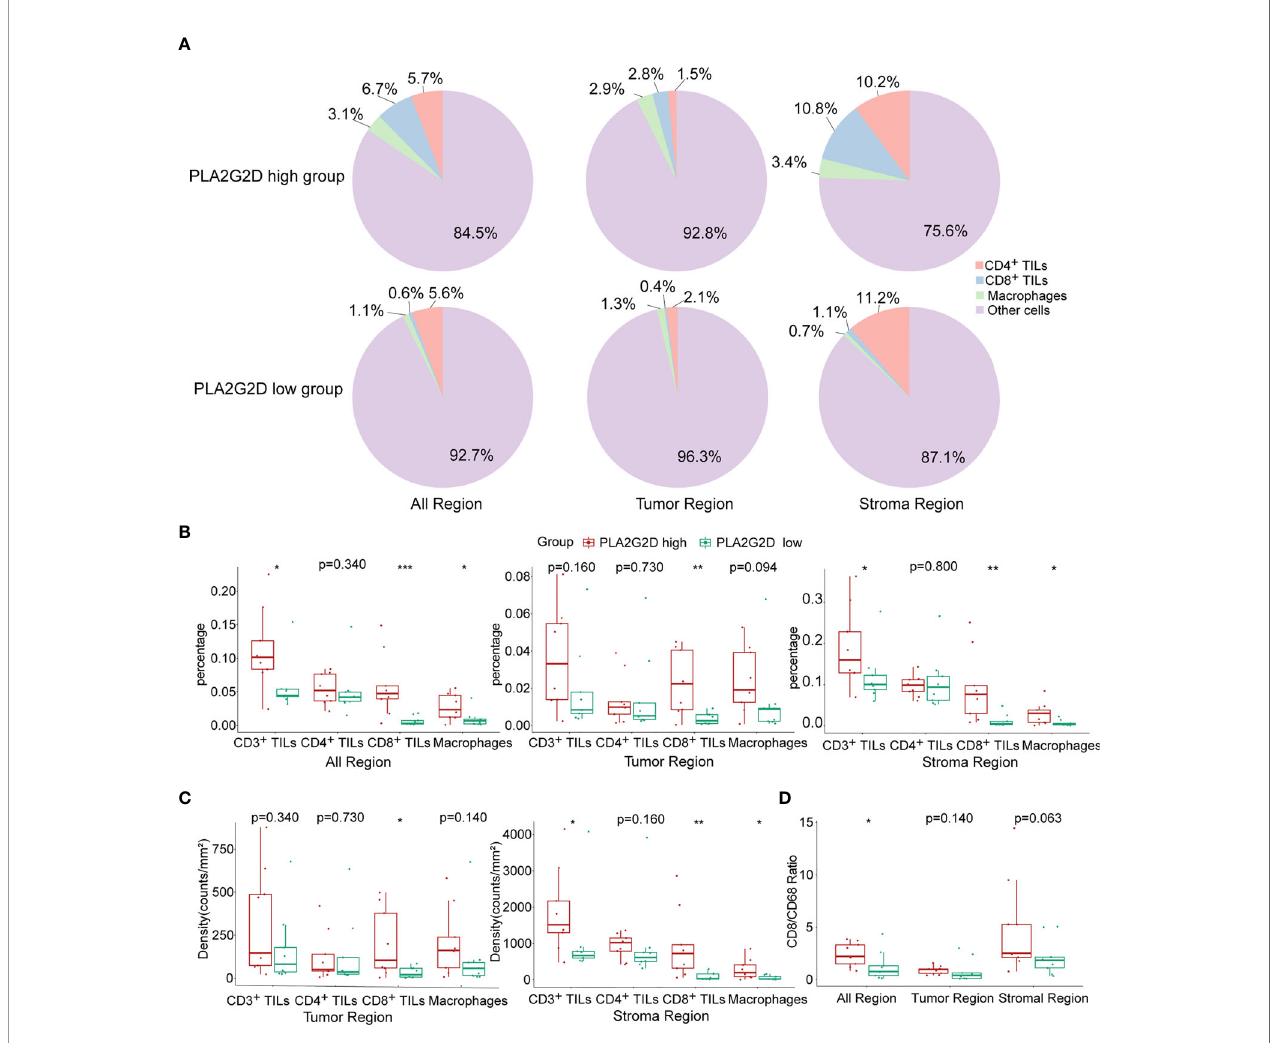
FIGURE 7 | Statistical analysis for mIHC staining. (A) Pie plots showing the composition of immune cells within different regions in PLA2G2D high- and low- expression groups. (B) Histograms showing the comparison of the percentage of individual immune cell populations between PLA2G2D high- and low- expression groups in different regions. (C) Histograms showing the comparison of the density of individual immune cell populations between PLA2G2D high- and low- expression groups in different regions. (D) Histogram showing the comparison of the CD8/CD68 ratio between PLA2G2D high- and low-expression groups in different regions. * P < 0.05, ** P < 0.01, and *** P <